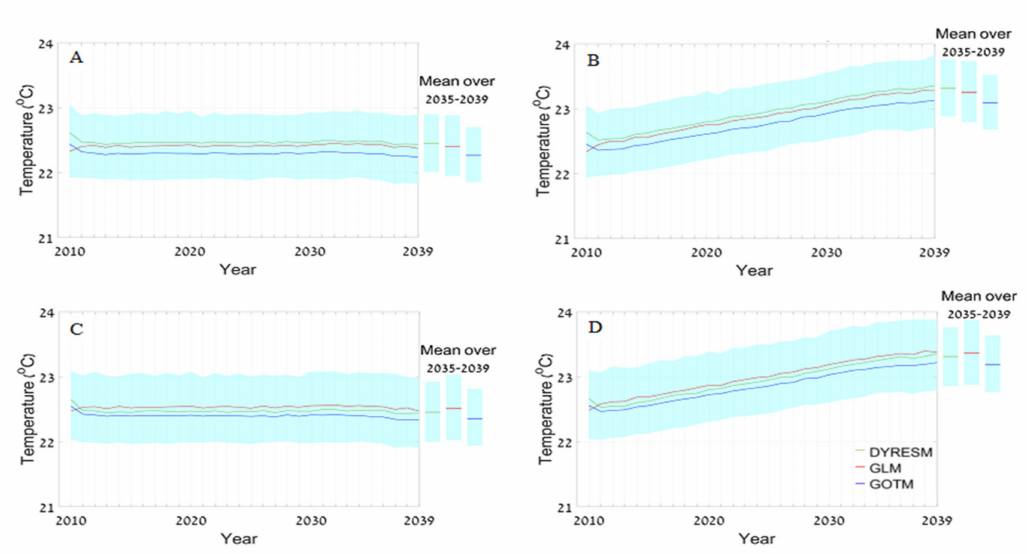
Figure 6. Mean annual water temperature values for 0–10 m layer. Results represent all realizations for the Unchanged ( A ), LI ( B ), HW ( C ) and HW-LI ( D ) scenarios. The blue areas represent the range of all results for all three models and the bars are the range and mean of the last 5 years of the simulations.